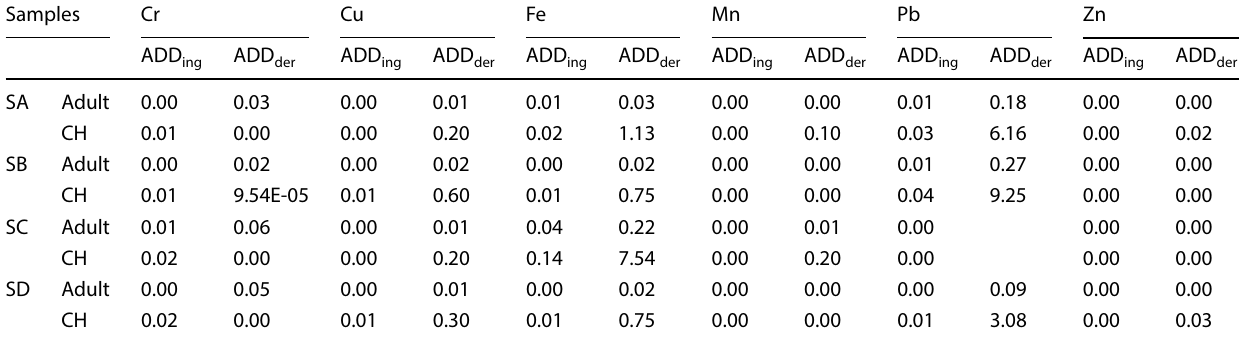
Table 6 Average Daily Dose via ingestion and dermal contact of the PTE in the water bodies (SA, SB, SC and SD) for adults and children